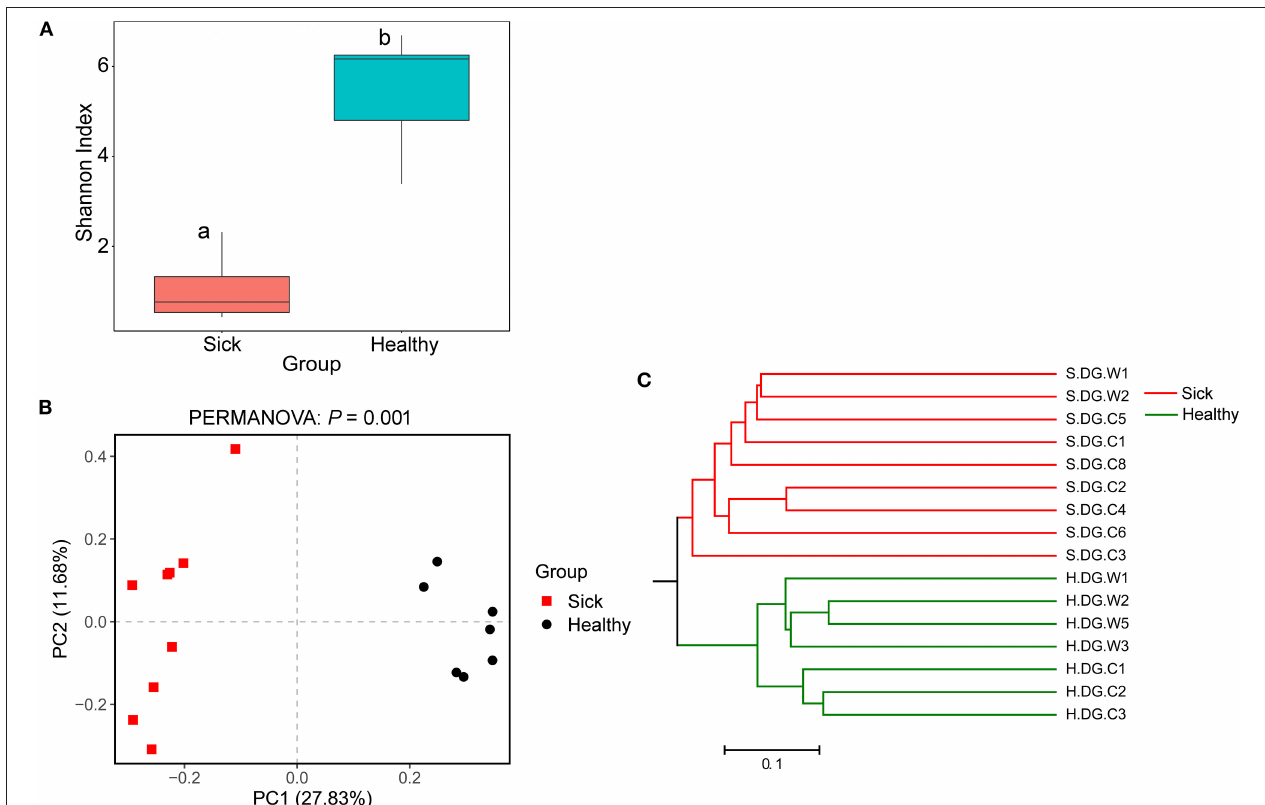
FIGURE 7 | Community diversity of the cutaneous mycobiome of crocodile lizards. (A) Alpha diversity indicated by Shannon index. Data with different superscript letters are significantly different ( P < 0.05) according to Wilcoxon test. (B) Beta diversity indicated by principal coordinate analysis (PCoA) and based on the unweighted UniFrac distance matrix. Numbers inside the parenthesis in the axis label show the percentage variation explained by each PC. P -value of PERMANOVA test is noted at the top of PCoA plot. (C) Beta diversity indicated by the UPGMA cluster based on the unweighted UniFrac distance